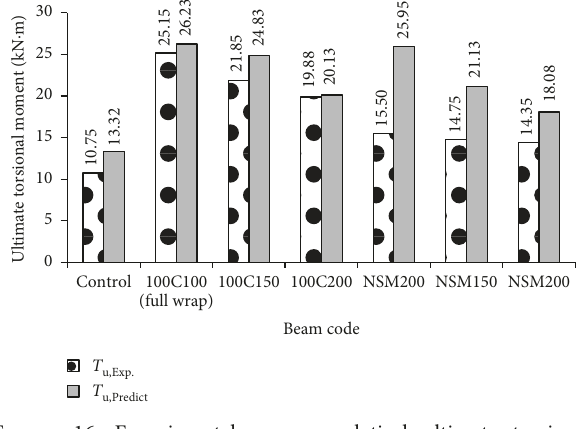
Figure 16: Experimental versus analytical ultimate torsional moments at each concrete beam.